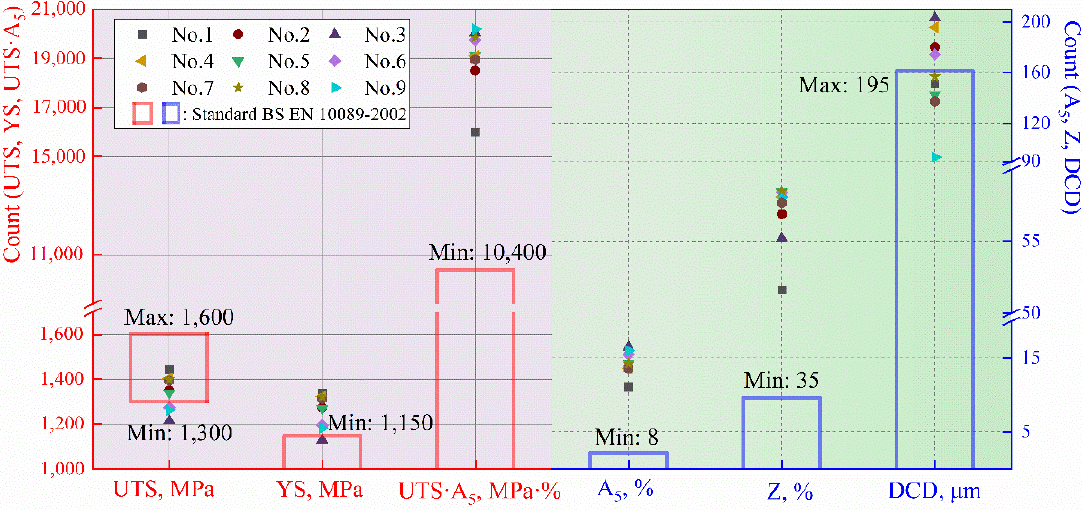
Figure 8. Comparison results of nine groups of experiments and the standard BS EN 10089-2002.